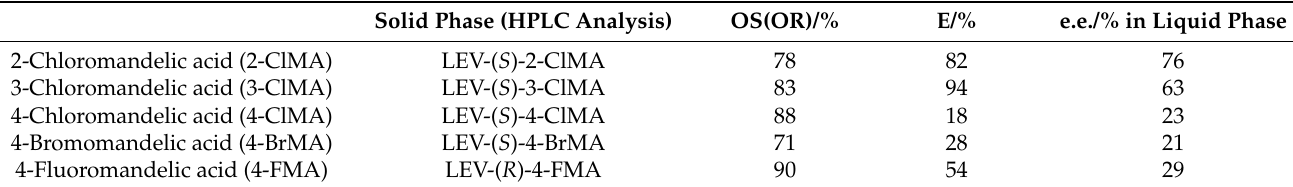
Table 1. Co-crystal resolution results of halogenated mandelic acids by LEV. Solid Phase (HPLC Analysis)